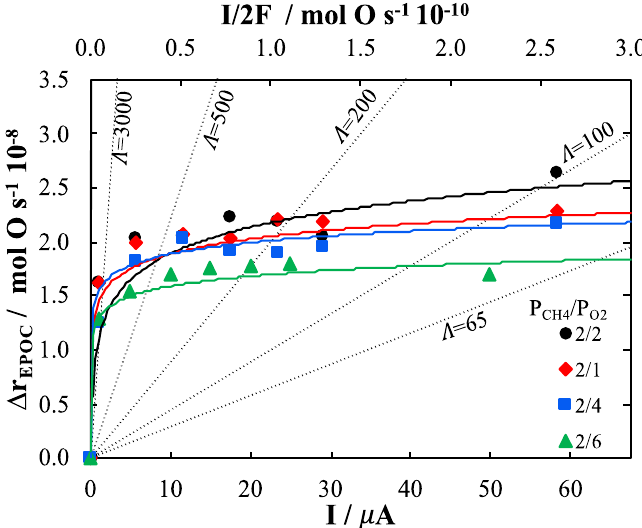
Figure 9. Current effect on catalytic rate in function of methane/oxygen ratio. T = 450 °C. Flow rate: 100 ccm.